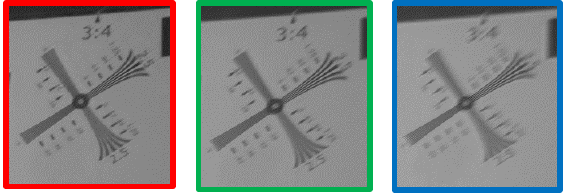
Figure 7. The colour dependant astigmatic aberrations noticed with the flat port (red on the left, green in the centre, blue on the right)